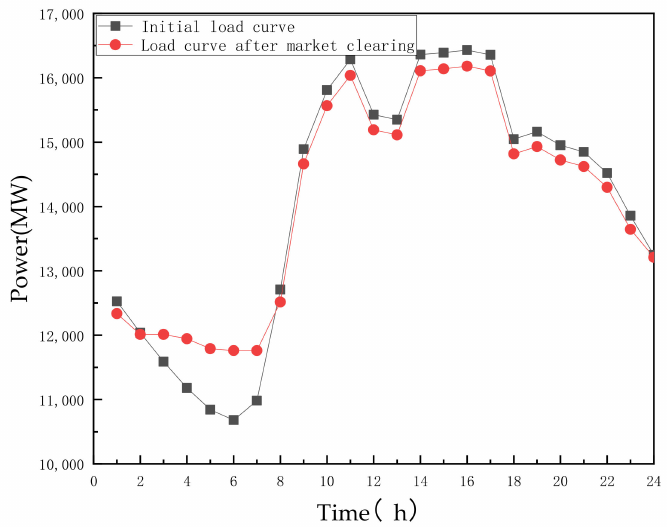
Figure 11. Load curve after the market clearing.